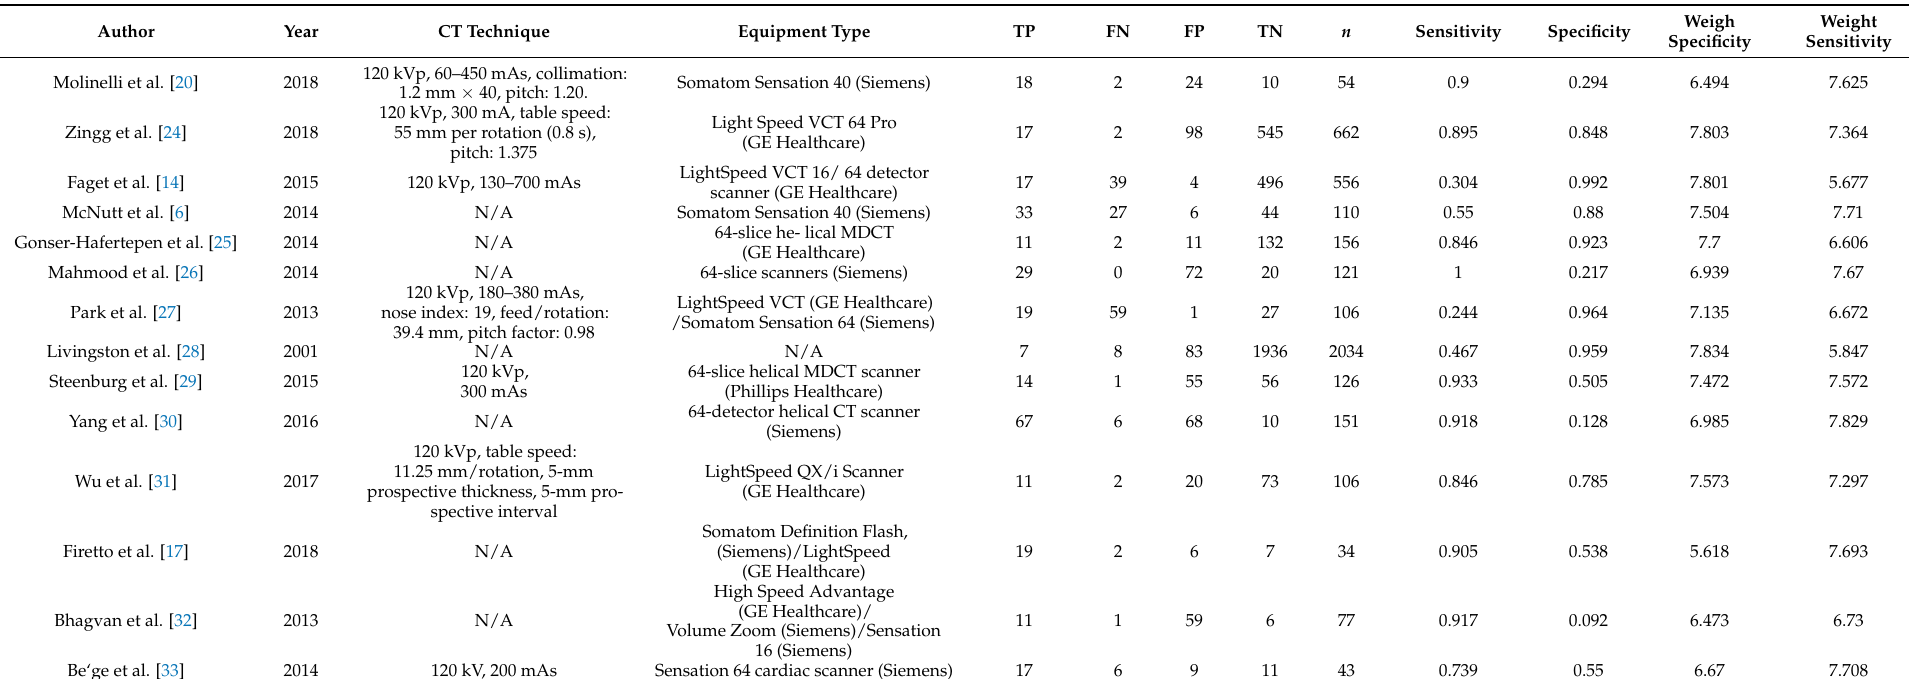
Table 1. The detail characteristics of included